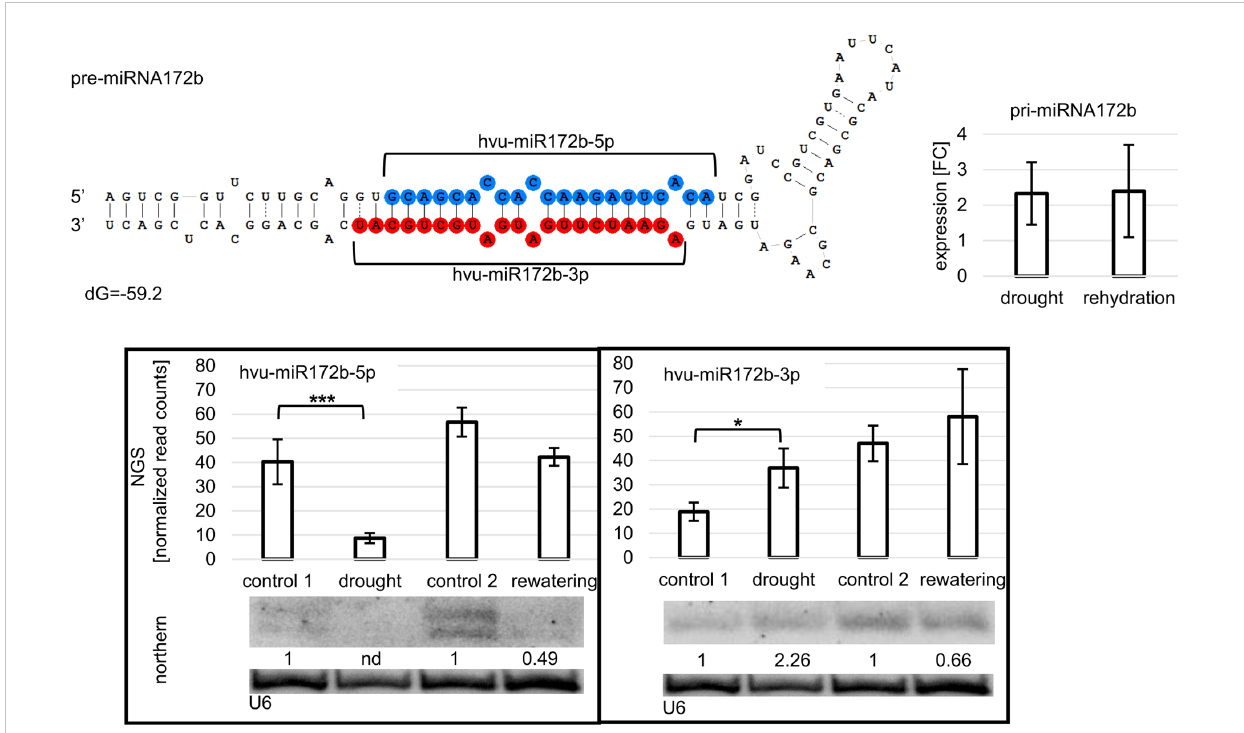
FIGURE 3 Hvu-miR172b-5p and hvu-miR172b-3p originating from a common precursor are differently expressed during drought. The pri-miRNA172b level is not signi fi cantly changed during drought or rehydration. Drought induces the downregulation of miRNA172b-5p, while the same treatment upregulates miRNA172b-3p. After rehydration, the accumulation of both molecules is at the control_2 level. Pri-miRNA expression was revealed by RT-qPCR; the results are shown as FC. Two-tailed Student ’ s t -test was used to calculate the signi fi cance of the result. The signi fi cance of the observed NGS differences was calculated with the DESeq package in R (***p ≤ 0.001, *p ≤ 0.05). The microRNA hybridization signal was corrected with U6 as a loading control. nd - not